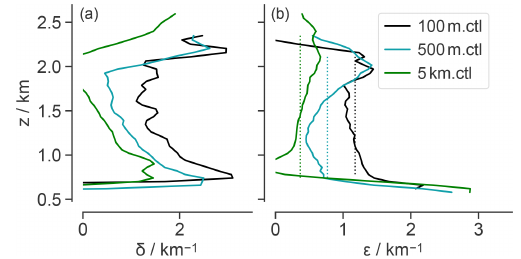
Figure 4. Cross section (note the different horizontal extent) of to- tal water specific humidity field and cloud cover at 42h simulation time in the ctl simulations for three different horizontal resolutions: (a) 100m, (b) 500m, (c) 5km. The total water specific humidity field is shown as contours evenly spaced every 0.5gkg − 1 , and cloud fraction is shaded in grey.